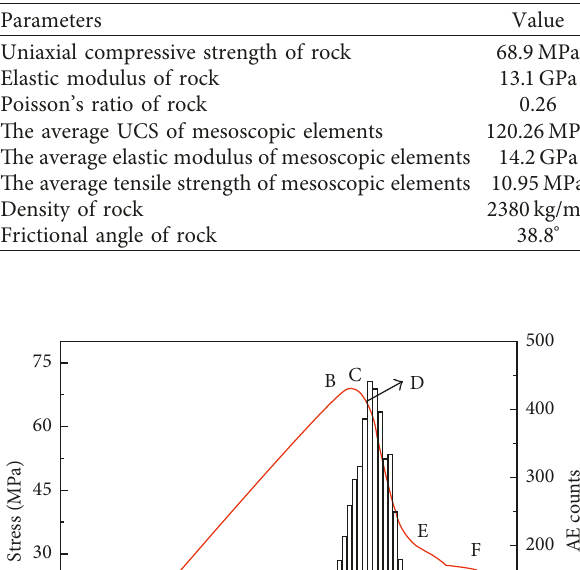
Table 2: Parameters obtained and used in the numerical